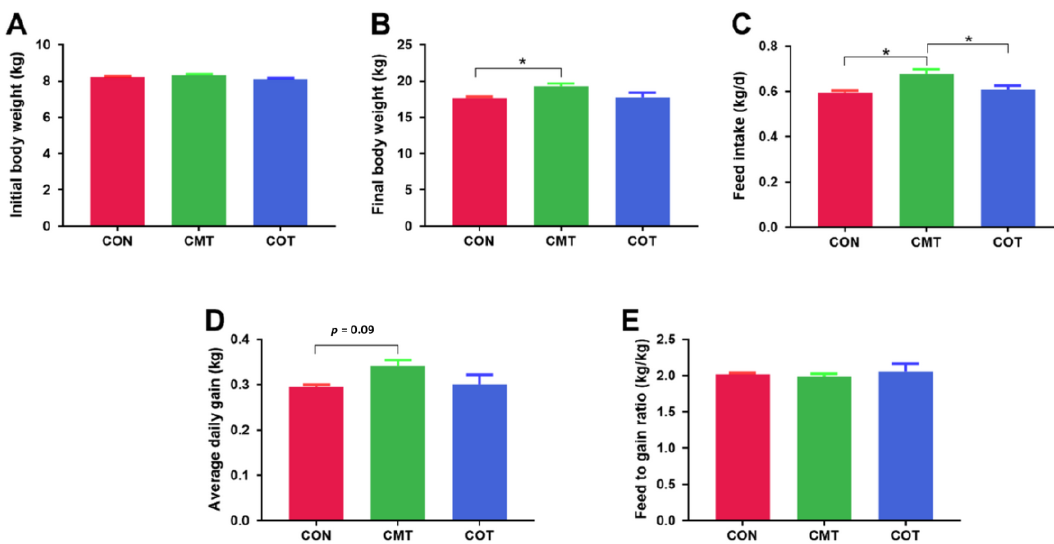
Figure 1. Growth performance of piglets in different treatments. ( A ) Initial body weight. ( B ) Final body weight. ( C ) Feed intake. ( D ) Average daily gain. ( E ) Feed to gain ratio. Star (*) indicates that there are significantly different (at the 5% threshold of the ANOVA) between groups.